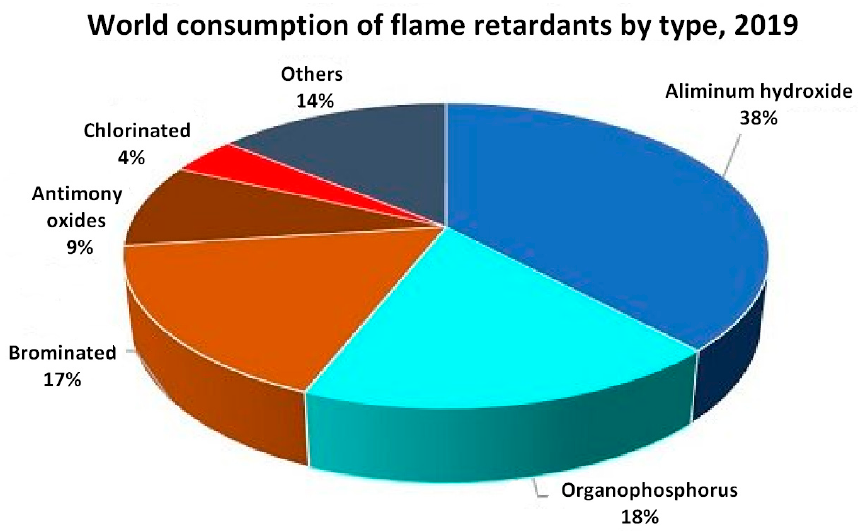
Figure 16. Global flame retardants (FRs) market categorized based on the chemistry [134].